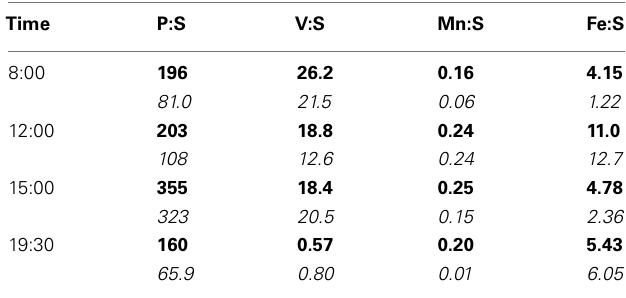
Table 5 | Comparison of S-normalized stoichiometries for P,V, Mn, and Fe measured at GSECARS and at